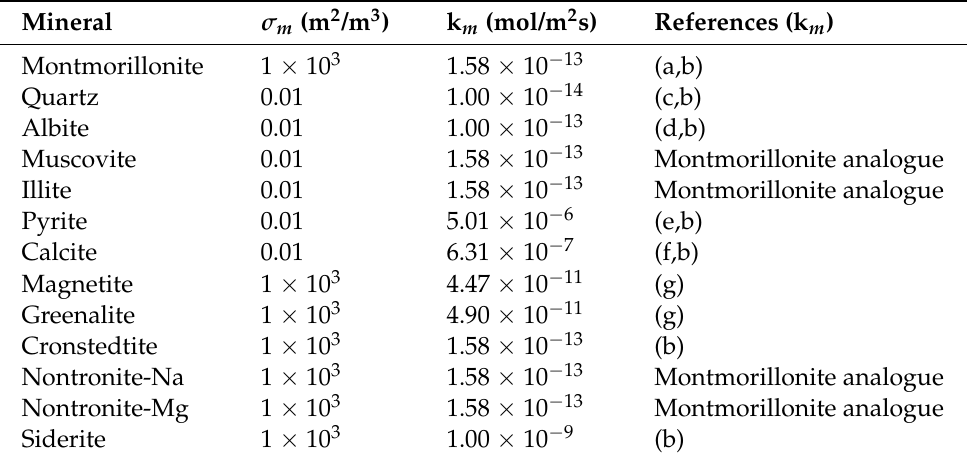
Table 7. Reactive surface areas and kinetic constants (at 25 ◦ C) of the primary minerals considered in the bentonite and the possible corrosion products. (a) Cama et al. [40] (b) Bildstein et al. [13] (c) Dove [41] (d) Knauss and Wolery [42] (e) Kamei and Ohmoto [43] (f) Plummer et al.